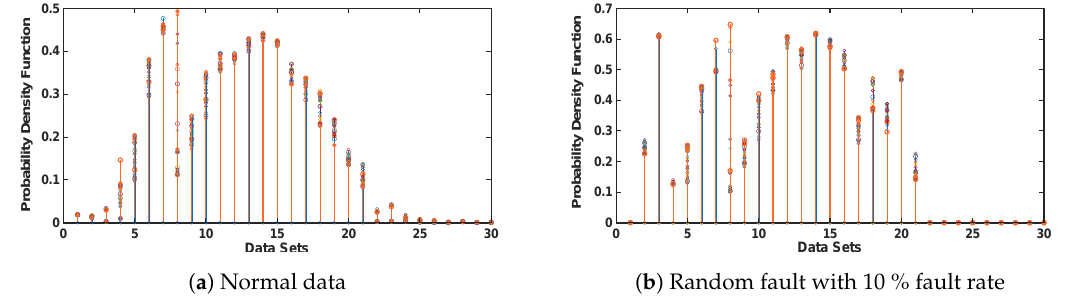
Figure 7. Dynamics of the sensor